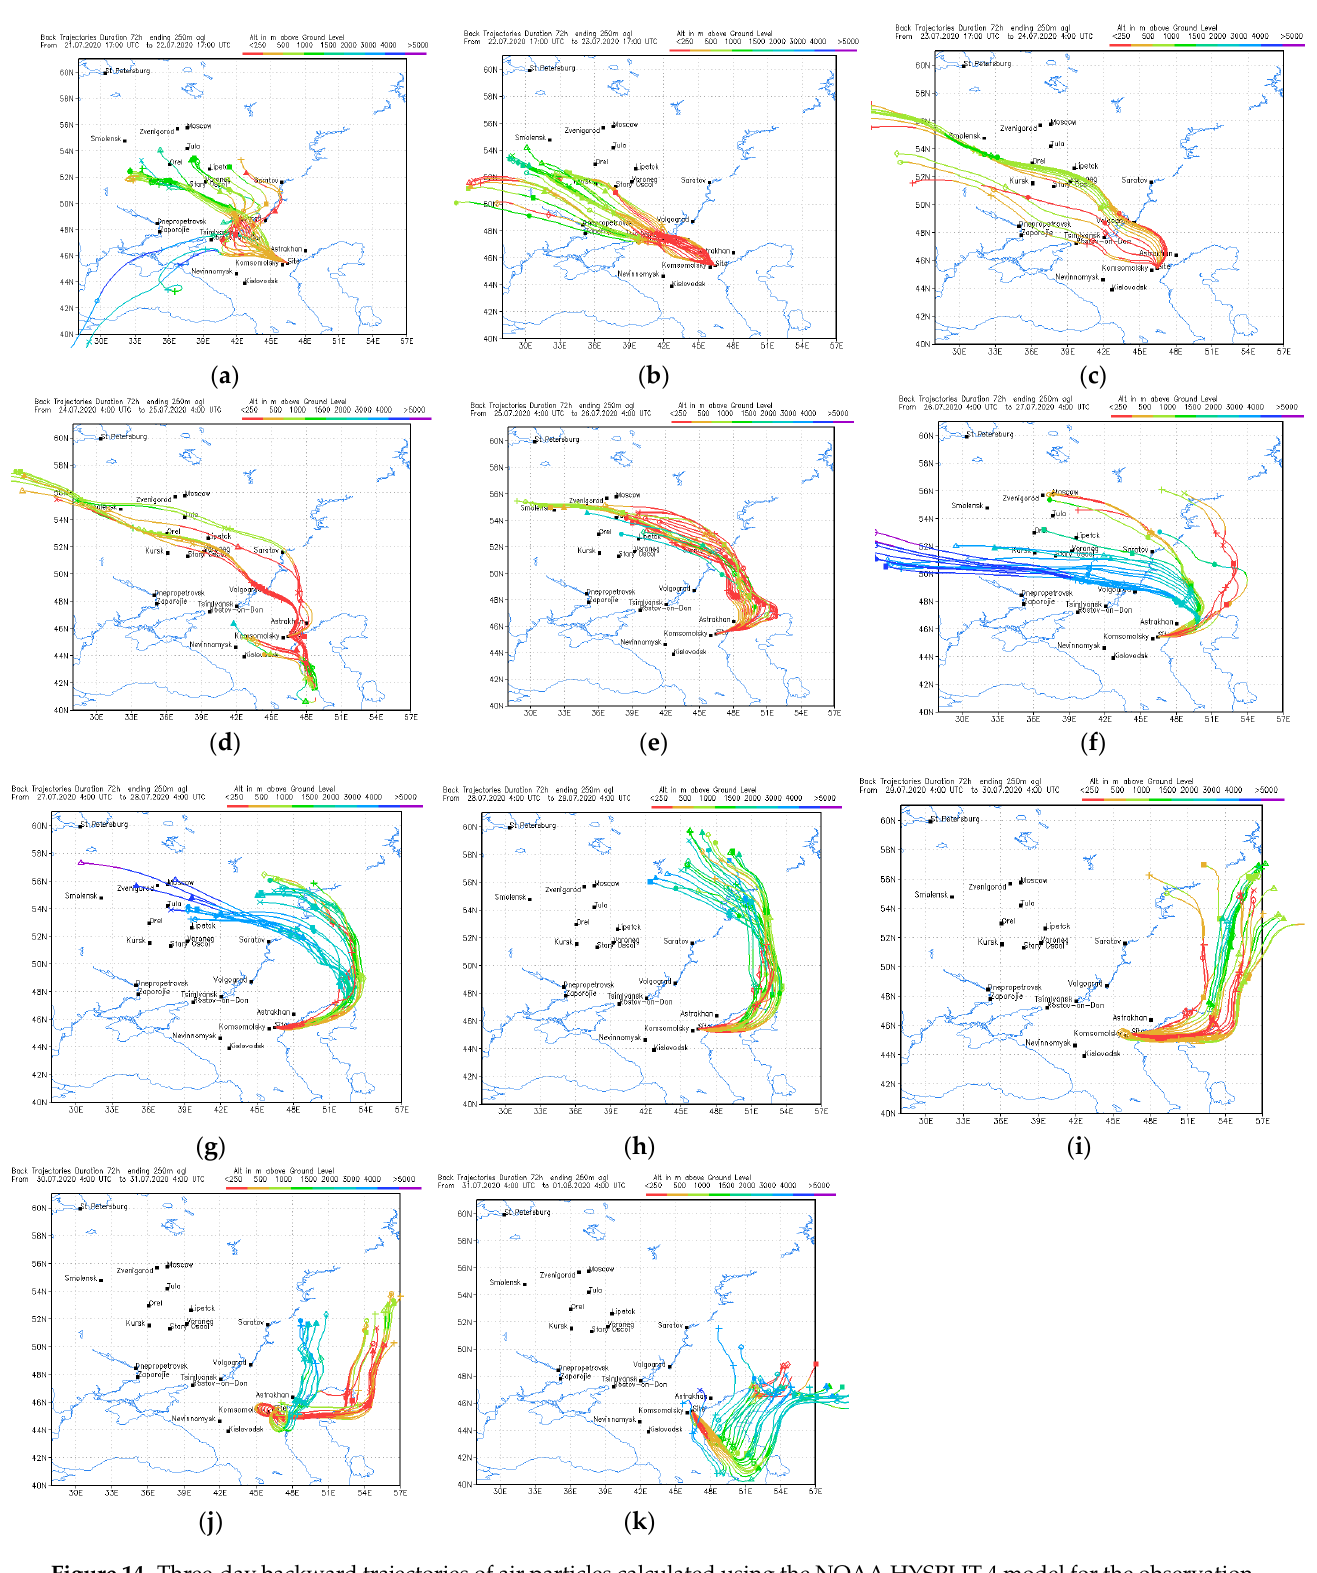
Figure 14. Three-day backward trajectories of air particles calculated using the NOAA HYSPLIT 4 model for the observation period in Kalmykia from July 21 ( a ) to July 31 ( k ), 2020. Trajectory drawings are listed sequentially from ( a ) to ( k ).